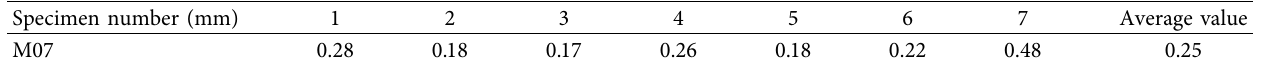
Figure 2: Fracture end face photo and fracture path sketch of the test piece. Table 1: Initial crack width of the rock sample terminal face.